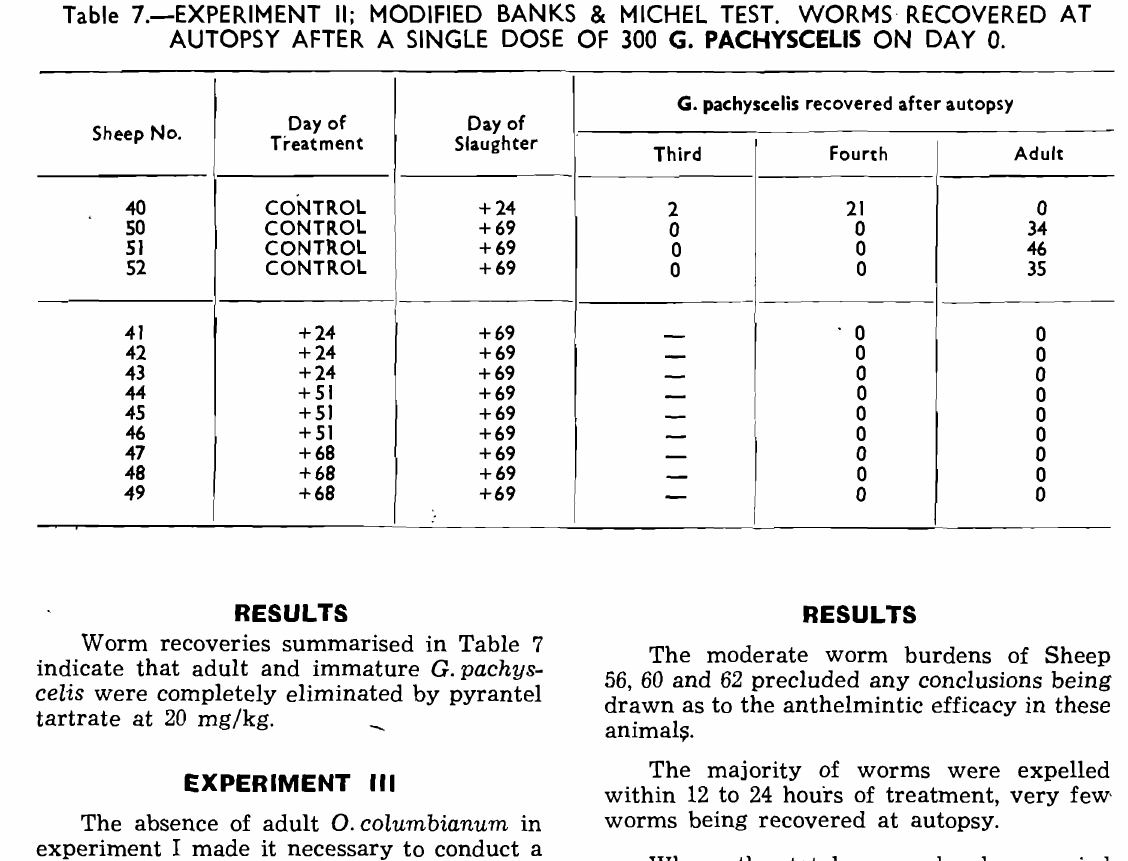
Table 7.-EXPERIMENT II; MODIFIED BANKS & MICHEL TEST. WORMS RECOVERED AT AUTOPSY AFTER A SINGLE DOSE OF 300 G. PACHYSCELIS ON DAY